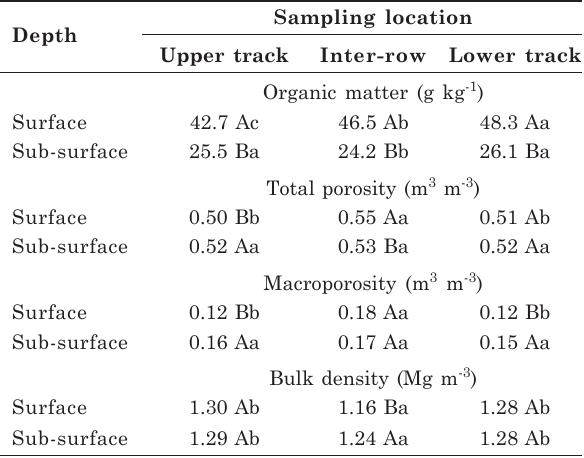
Means with the different lower-case letter in each row and with the different capital letter in each column for each soil property are significantly different at the 5 % level by the Scott-Knott